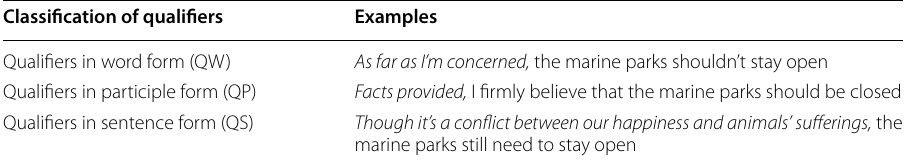
Table 2 Classification and examples of defined components (Berger,